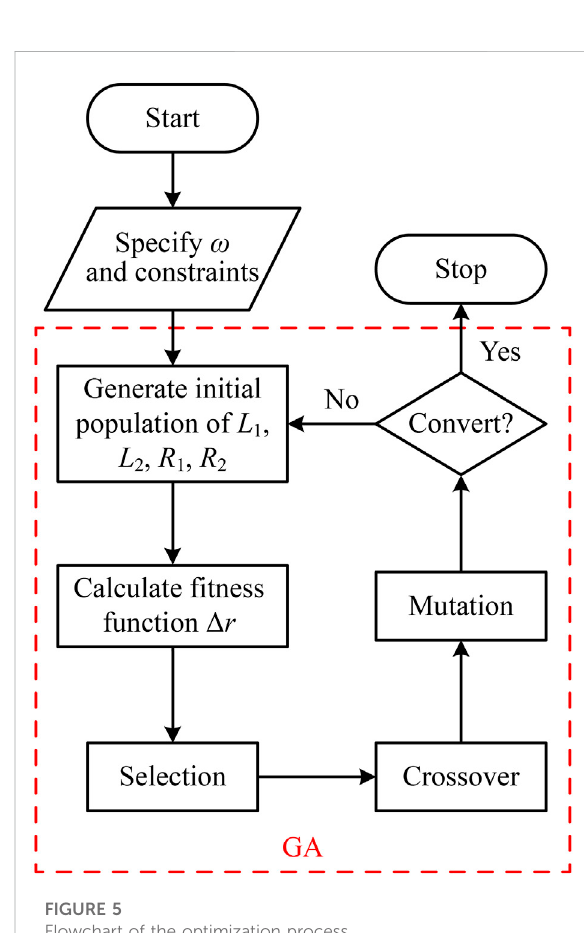
Flowchart of the optimization